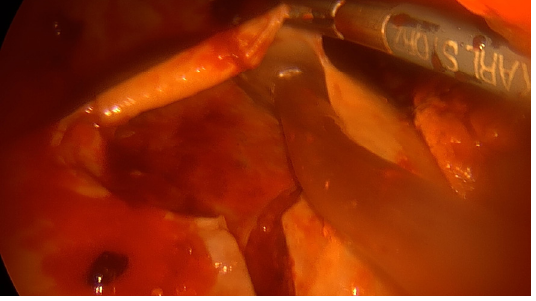
Figure 4. VATS decortication.